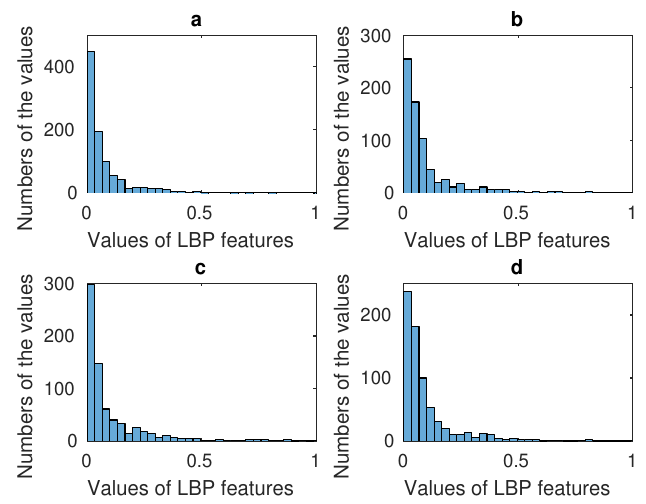
Figure 7. ( a ) Display model of the mouth’s LBP features; ( b ) Display model of the left cheek’s LBP features; ( c ) Display model of forehead’s LBP features; ( d ) Display model of the right cheek’s LBP features.